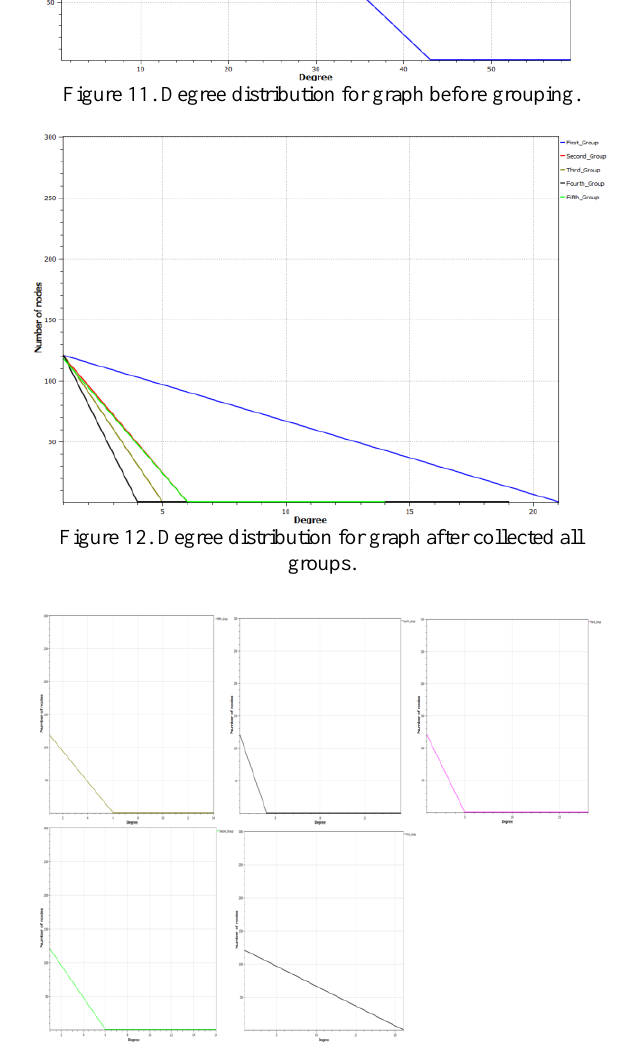
Figure 13. Degree distribution for graph for each group.